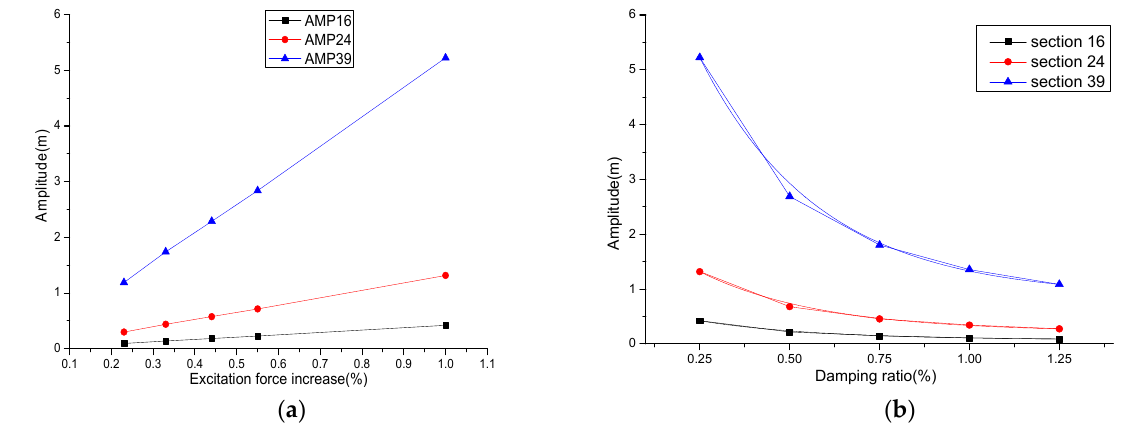
Figure 9. The relationship between exciting forces, damping ratio, and amplitude. ( a ) Excitation force